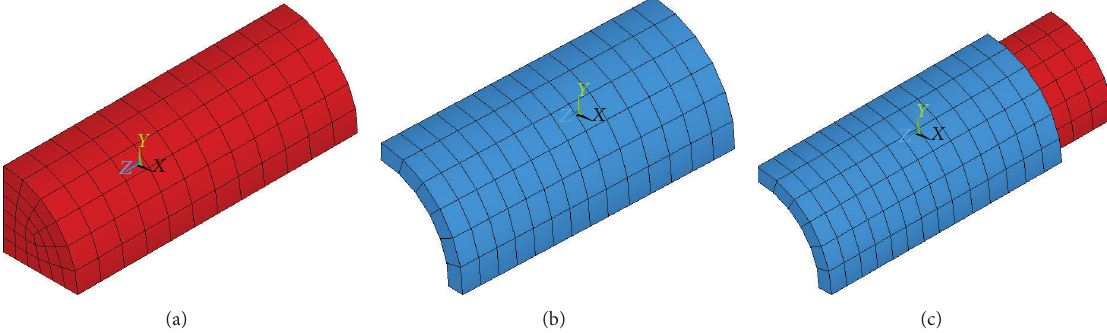
Figure 8: Numerical model of the original CFD; (a) shaft, (b) cylinder, and (c) assembled CFD.